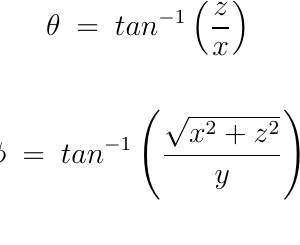
Figure 2. Inverse depth point